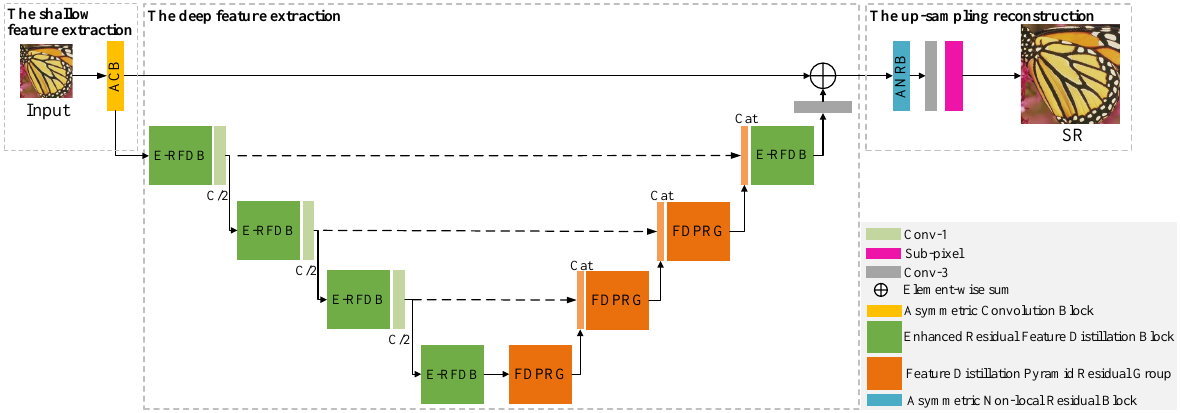
Figure 2. The architecture of the proposed U-shaped residual network